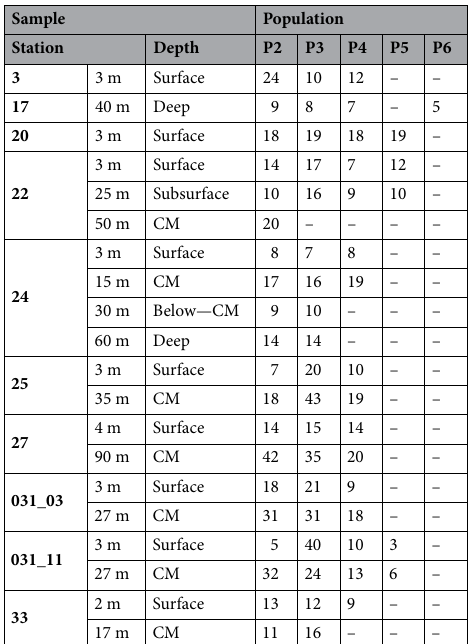
Table 2. Operational taxonomic units (OTUs) counts per population. CM, chlorophyll